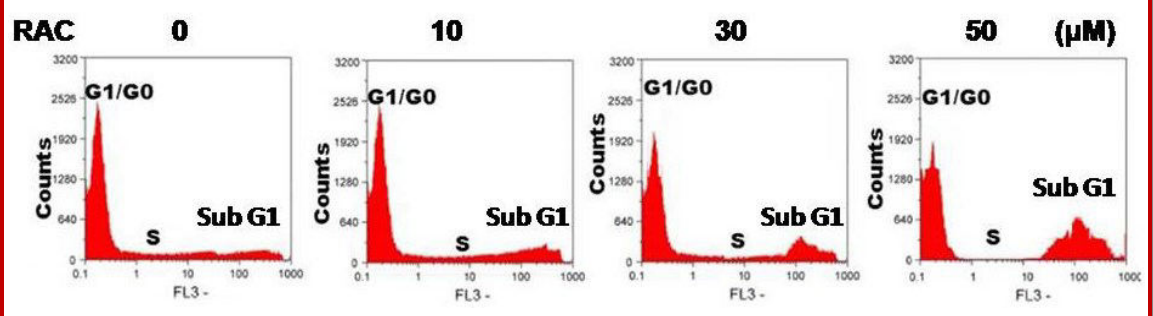
Figure 6: 2-Florobenzaldehyde retinoic increases the population of cells in G0-G1 phase in after 24 hours and in sub-G1 phase after 48